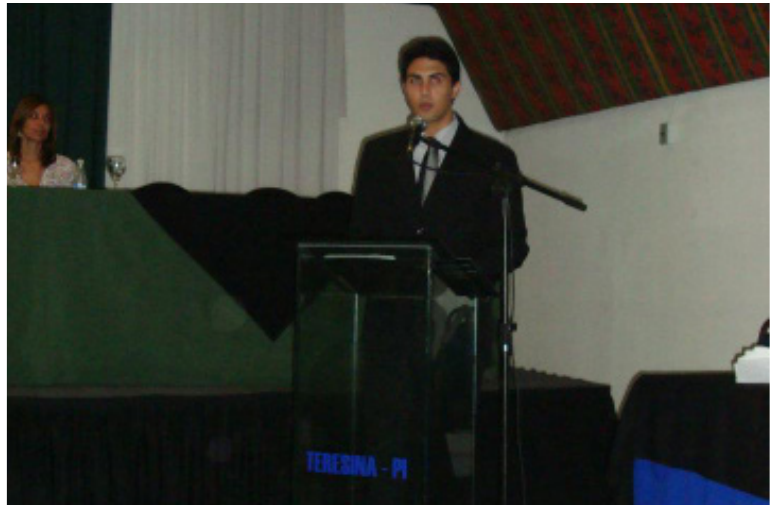
See photos of the COMAPI on the next